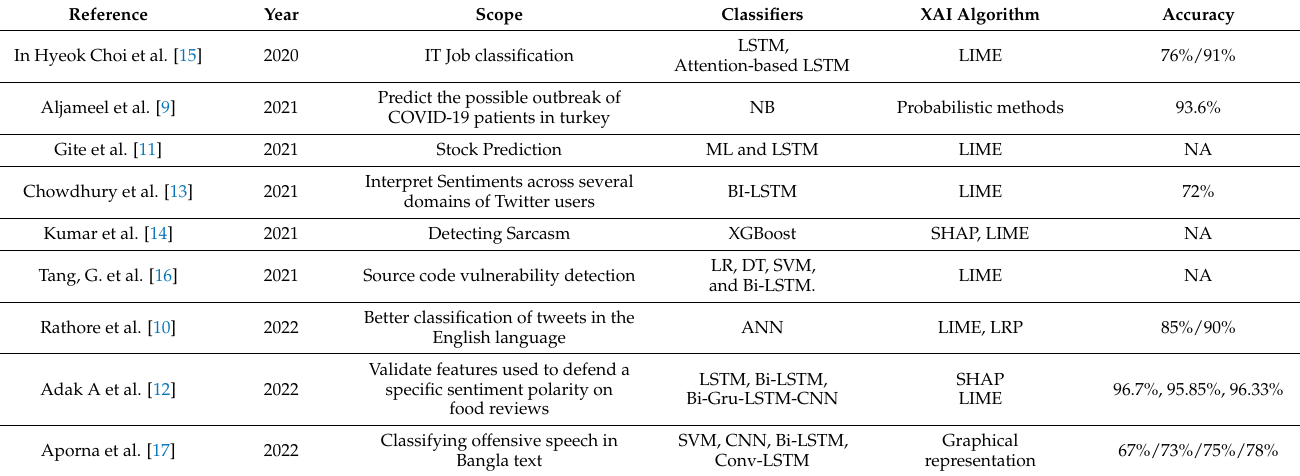
Table 1. Previous work in which LIME was applied to DL